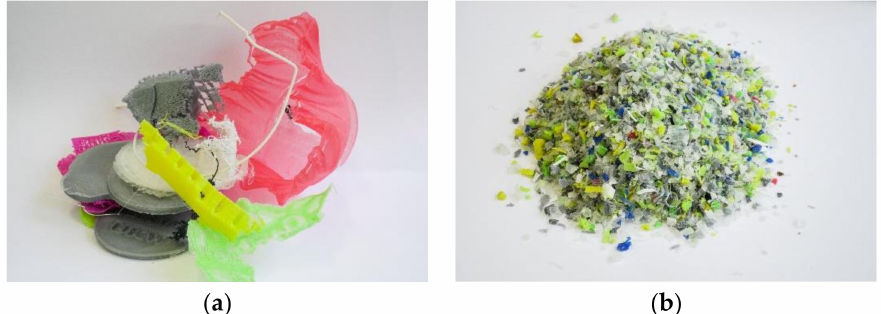
Figure 1. Appearance of polylactide waste: ( a ) after 3D printing, ( b ) after grinding.